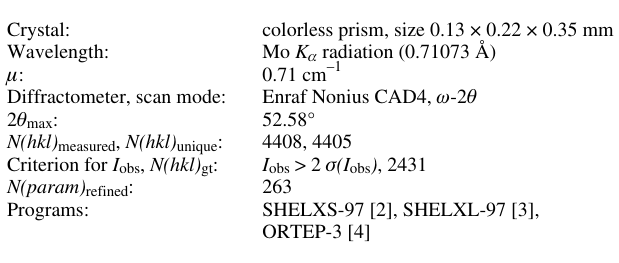
Table 1. Data collection and